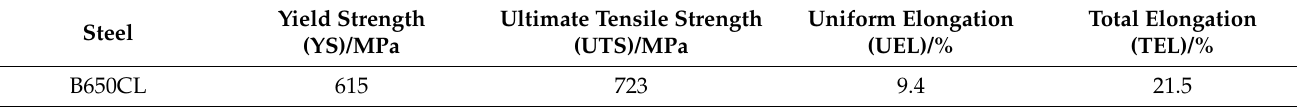
Table 2. Mechanical properties of test material.